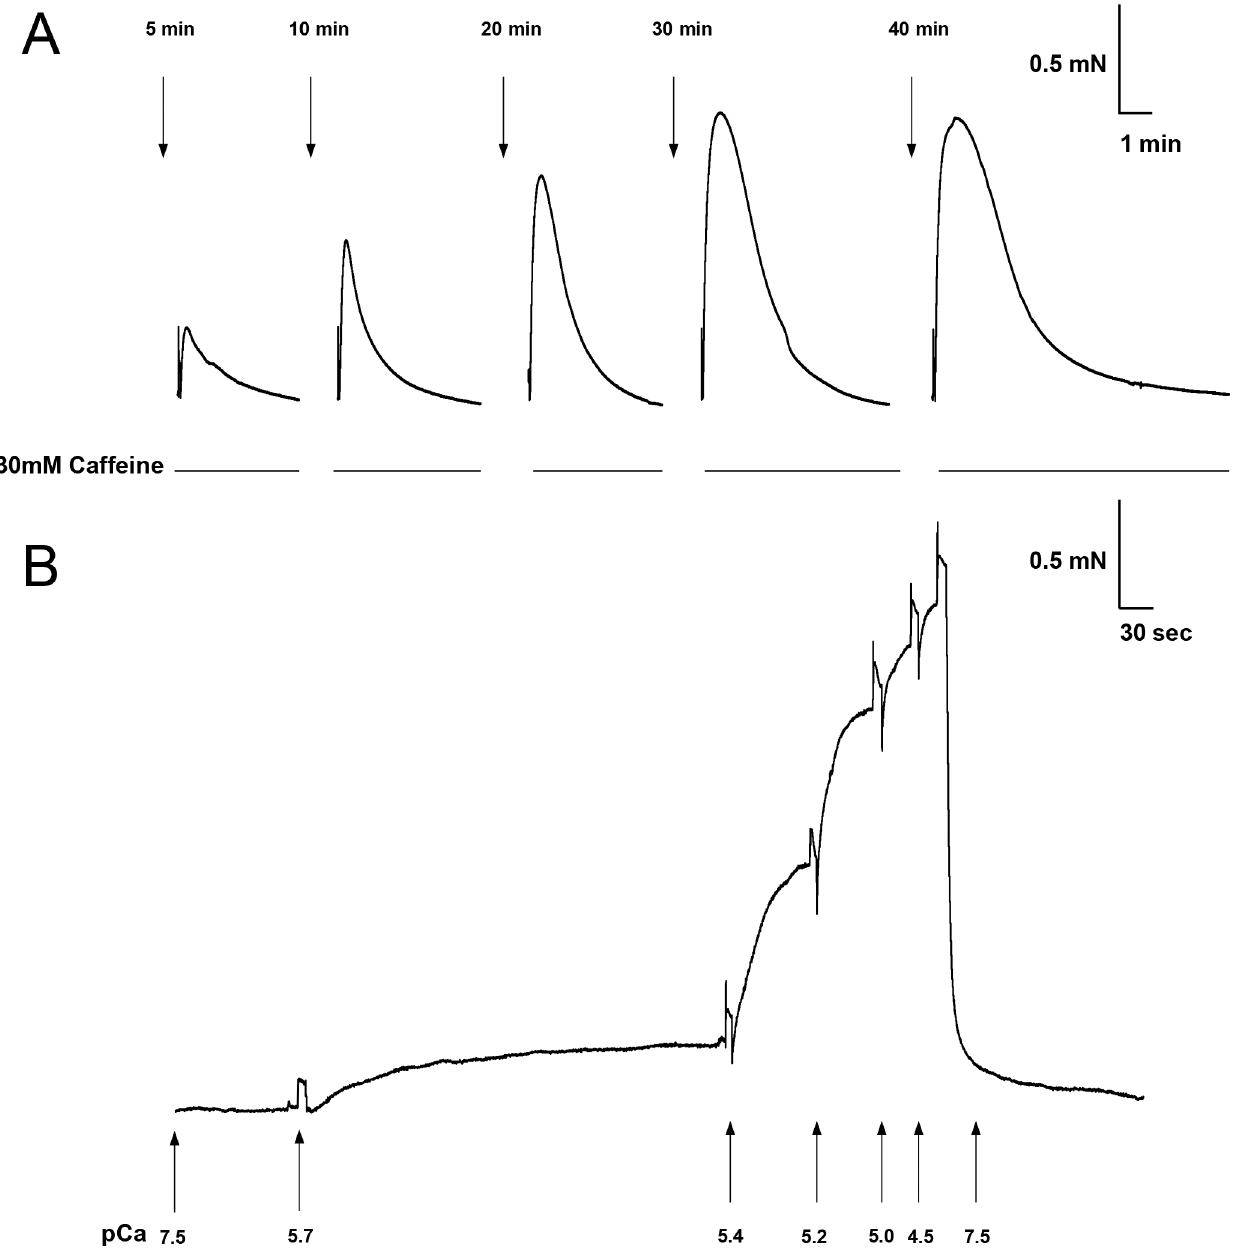
Fig 1. Example recordings of both caffeine-induced and Ca 2+ -activated force responses from a single cardiomyocyte bundle. (A) After skinning with 50ug.ml -1 saponin for 25 mins, a bundle was exposed to a load /release protocol (see methods) to ascertain the SR loading and Ca 2+ storage properties. From left to right, the trace shows force responses to 30mM caffeine (solid line) after various load times (downward arrows). (B) The same bundle was skinned with Triton X-100 for 20 min, and the Ca 2+ sensitivity and maximum Ca 2+ -activated force responses were then determined by exposing the bundles to heavily buffered Ca-EGTA solutions with increasing free [Ca 2+ ] (pCa: 7.5, 5.7, 5.4, 5.2, 5.0, 4.5 as indicated by the upward arrows,